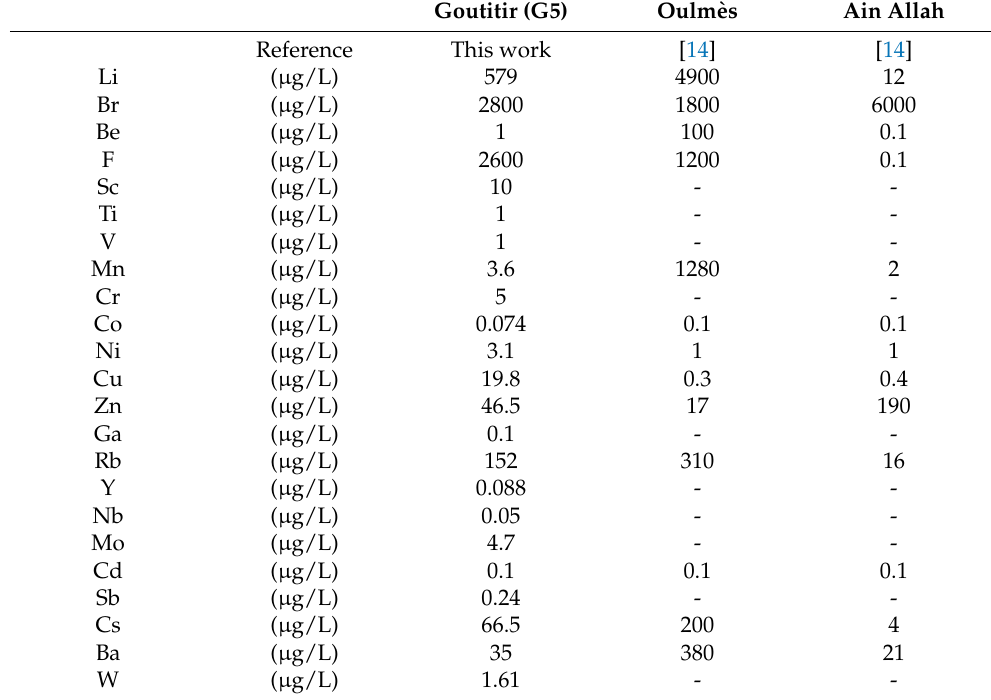
Table 2. Minor and trace elements dissolved in the thermal waters of (This work 2019), Oulm è s and Ain Allah